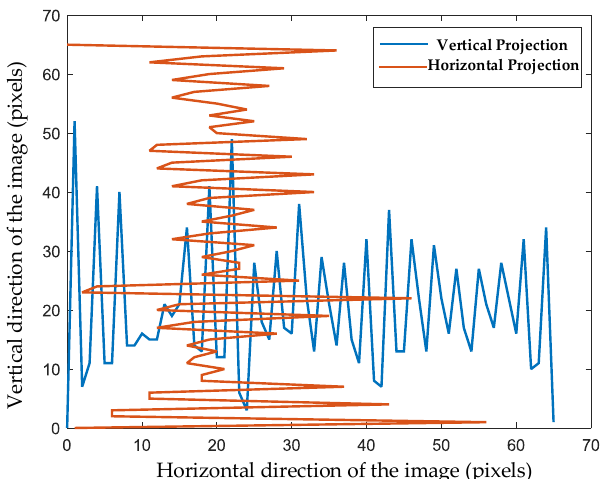
Figure 14. Waveform diagram of the projection of the QR code contours in the horizontal and vertical directions.